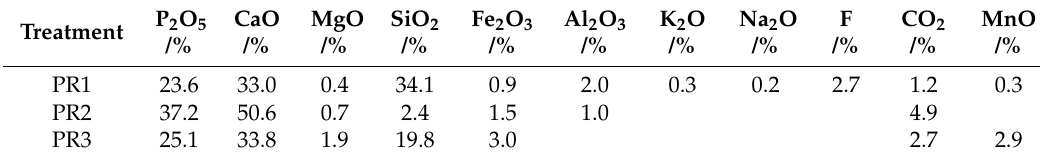
Table 1. Chemical composition of the selected phosphate rock (PR) powders.